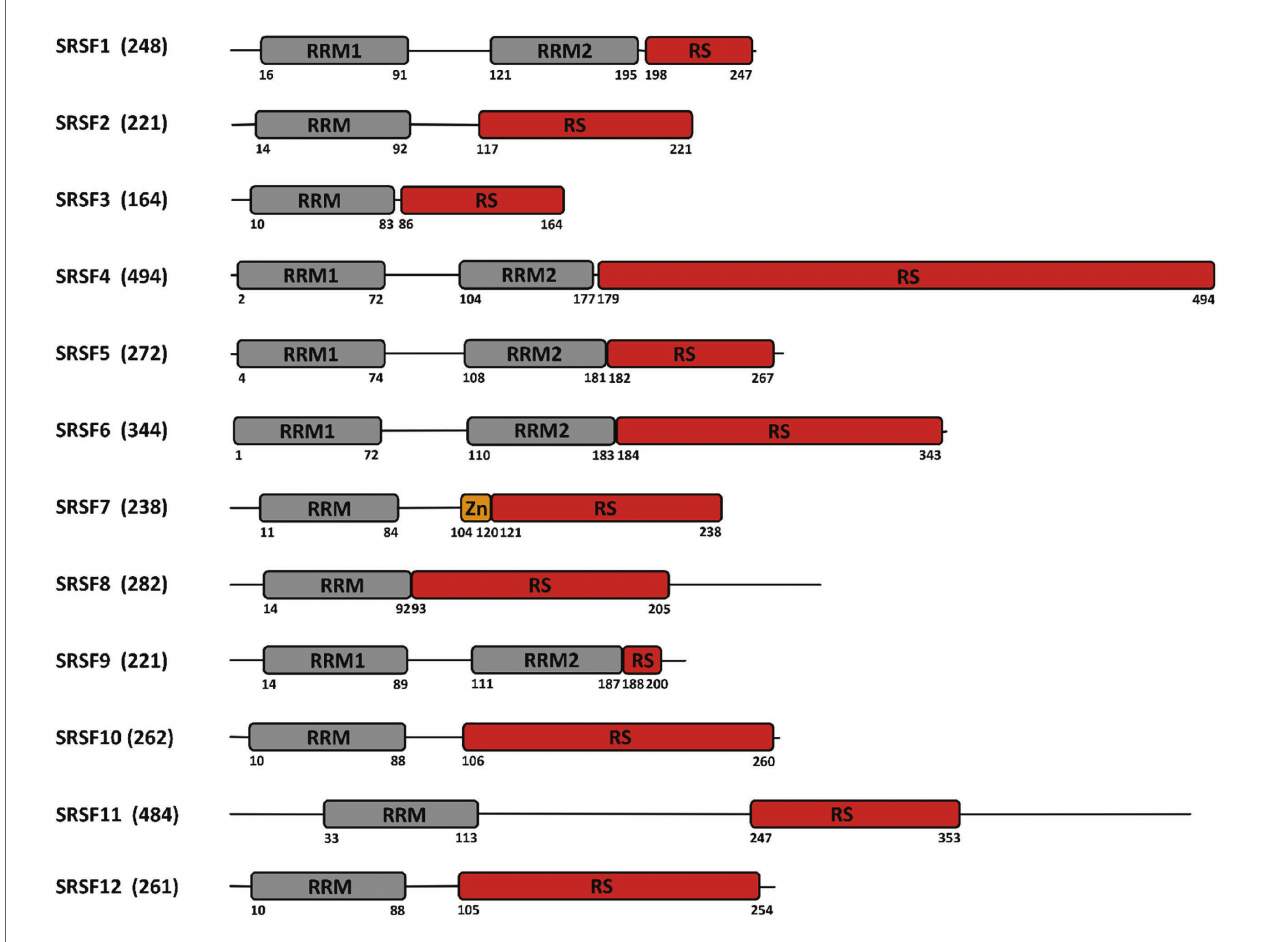
FIGURE 2 | Structure of the SR-proteins family. The human family of SR proteins is composed by 12 proteins that share a similar modular organization with one or two RNA recognition motifs (RRM) in their N-terminal part, followed by a length-variable serine/arginine-rich (RS) domain in their C-terminal part. SRSF7 contains an additional zinc finger (Zn) domain. Numbers below the sequence refer to the amino acid position. The total number of amino acids is indicated between parentheses close to the protein